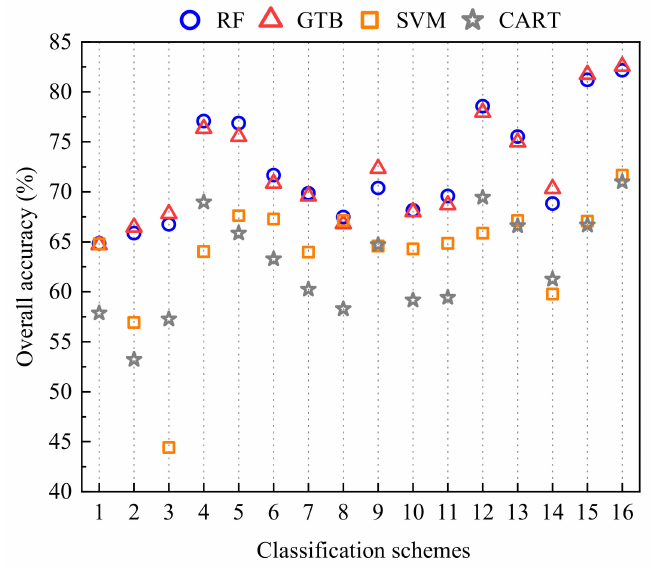
Figure 3. Overall accuracy of the different classification schemes and